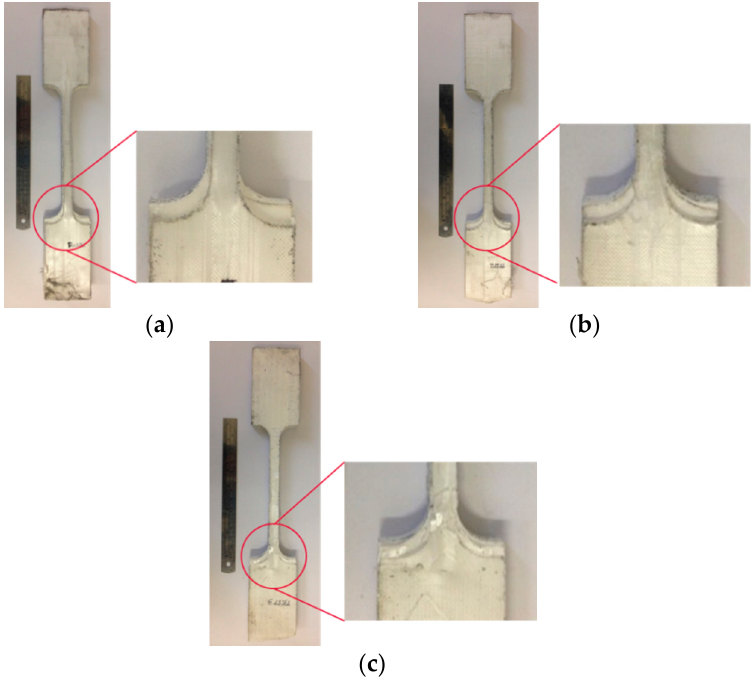
Figure 9. Dyneema ® HB26 (10 mm thick) tested at different crosshead displacement rates: ( a ) 10 mm/min; ( b ) 5 mm/min; ( c ) 1 mm/min.